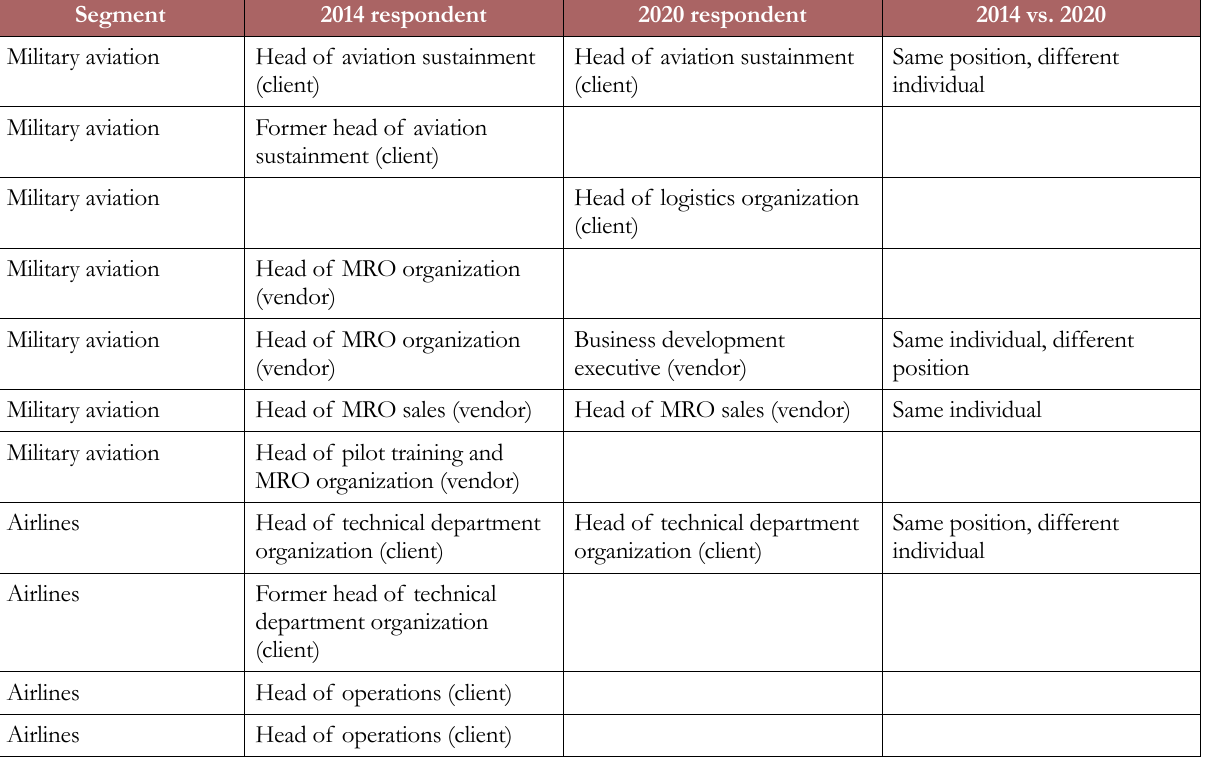
Table 1. Respondents for the aviation MRO outsourcing